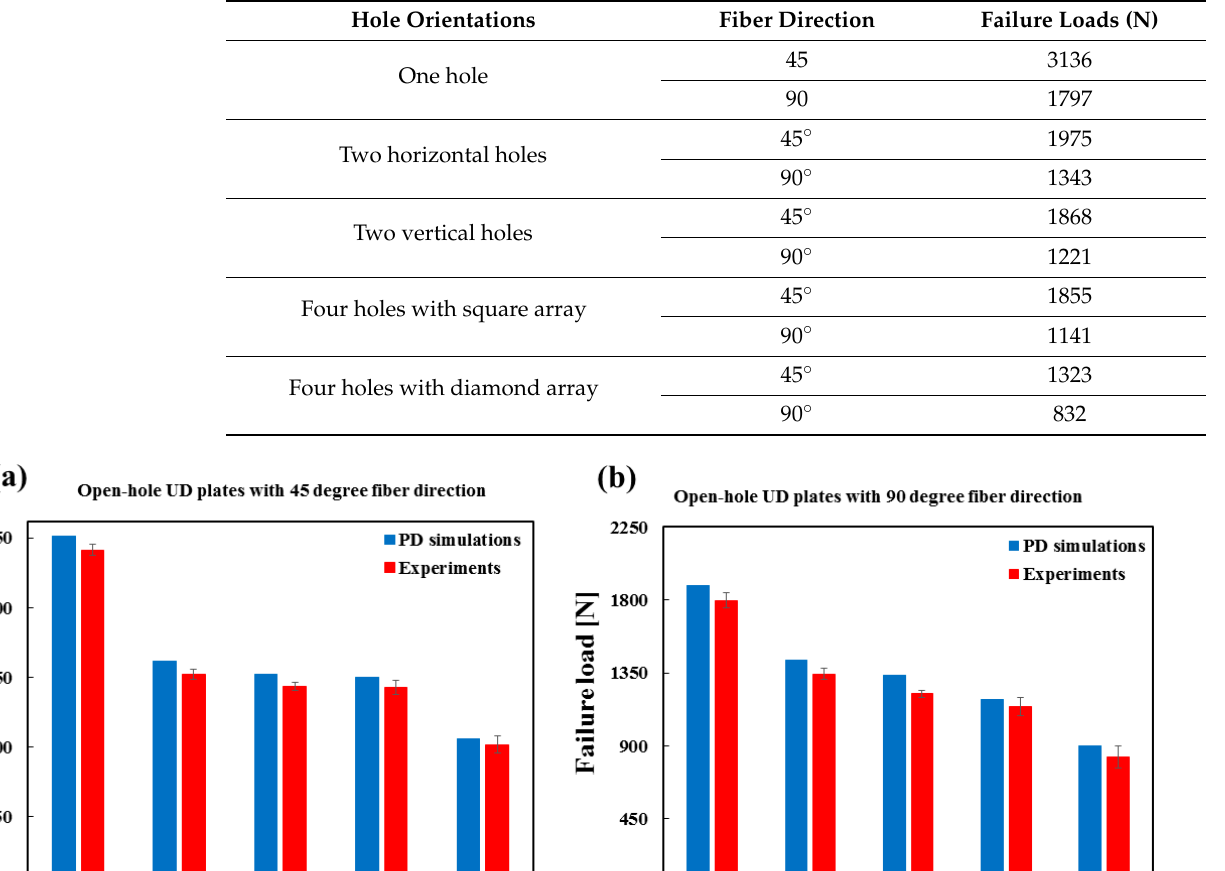
Table 2. Failure loads of unidirectional plates with different hole orientations and fiber directions obtained by the tensile test.